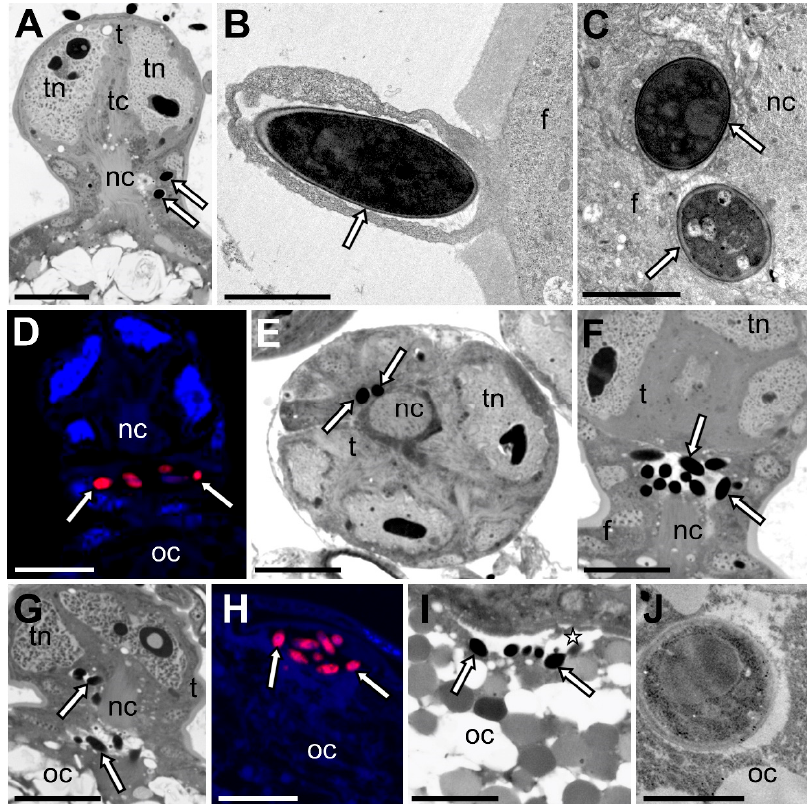
Figure 4. Consecutive stages of symbiont transmission between generations ( A , B ). Longitudinal section through the ovariole of Parthenolecanium fletcheri . Symbiotic fungi (white arrows) invade the follicular cells in the neck region of the ovariole ( A ). Light microscope, scale bar = 20 µ m ( B ). TEM, scale bar = 2 µ m ( C , D ). Symbiotic fungi in the cytoplasm of follicular cells of Parthenolecanium pomeranicum ( C ) and Eulecanium tiliae ( D ). ( C ) TEM, scale bar = 2 µ m ( D ). Confocal microscope, scale bar = 20 µ m ( E , F ). Symbiotic fungi surrounding the nutritive cord ( E ). Parthenolecanium pomeranicum ( F ). Parthenolecanium fletcheri ( E , F ). Light microscope, scale bar—20 µ m ( G ). Symbiotic fungi move along the nutritive cord to the perivitelline space of Parthenolecanium fletcheri . Light microscope, scale bar = 20 µ m ( H ). Symbiotic fungi gather in the invagination of the perivitelline space of Eulecanium tiliae . Confocal microscope, scale bar = 20 µ m ( I ). Migration of symbionts from the perivitelline space to the oocyte cytoplasm of Psilococcus ruber . Light microscope, scale bar = 20 µ m ( J ). Symbiotic microorganism in the oocyte cytoplasm of Psilococcus ruber. TEM, scale bar = 2 µ m. f—follicular cell, nc—nutritive cord; oc—oocyte, t—trophocyte, tc—trophic core, tn—trophocyte nucleus, white arrow—fungal symbiont; asterisk—perivitelline